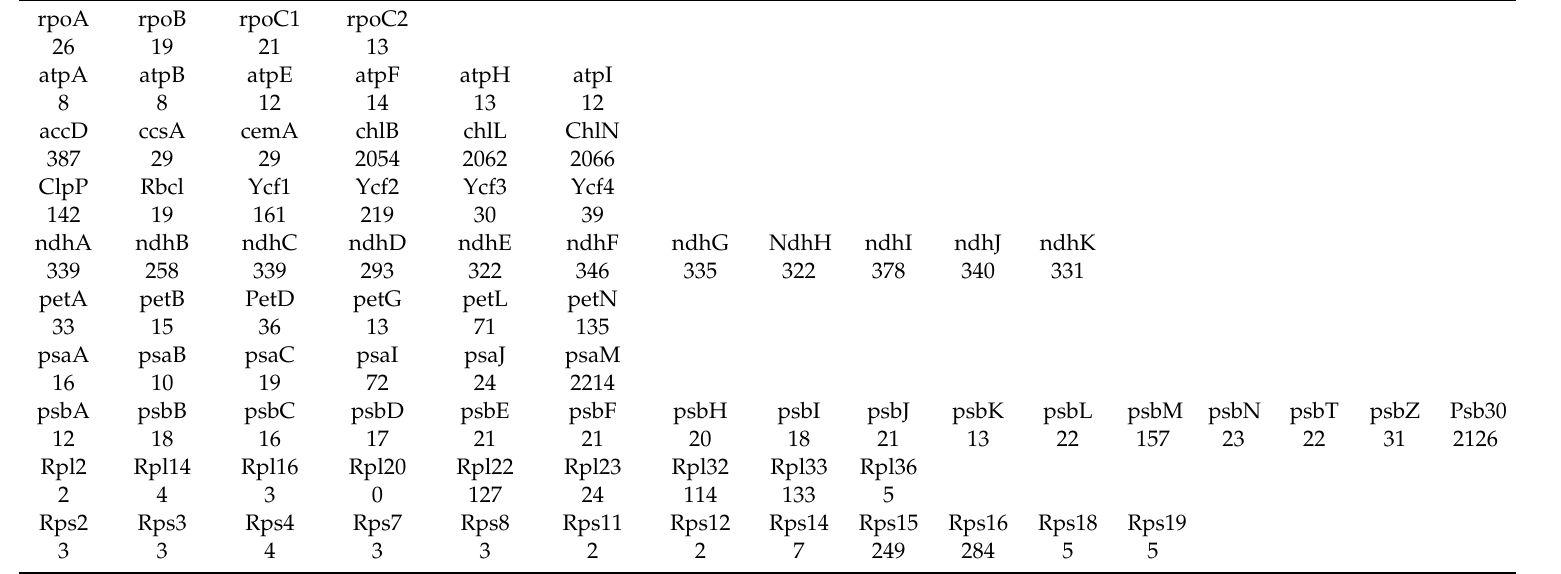
Table 2. Deletion of di ff erent genes in the chloroplast genomes. Almost all of the genes have been deleted in the chloroplast genome of one or another species. However, Rpl20 was found to be the most intact gene and found in all the species studied so